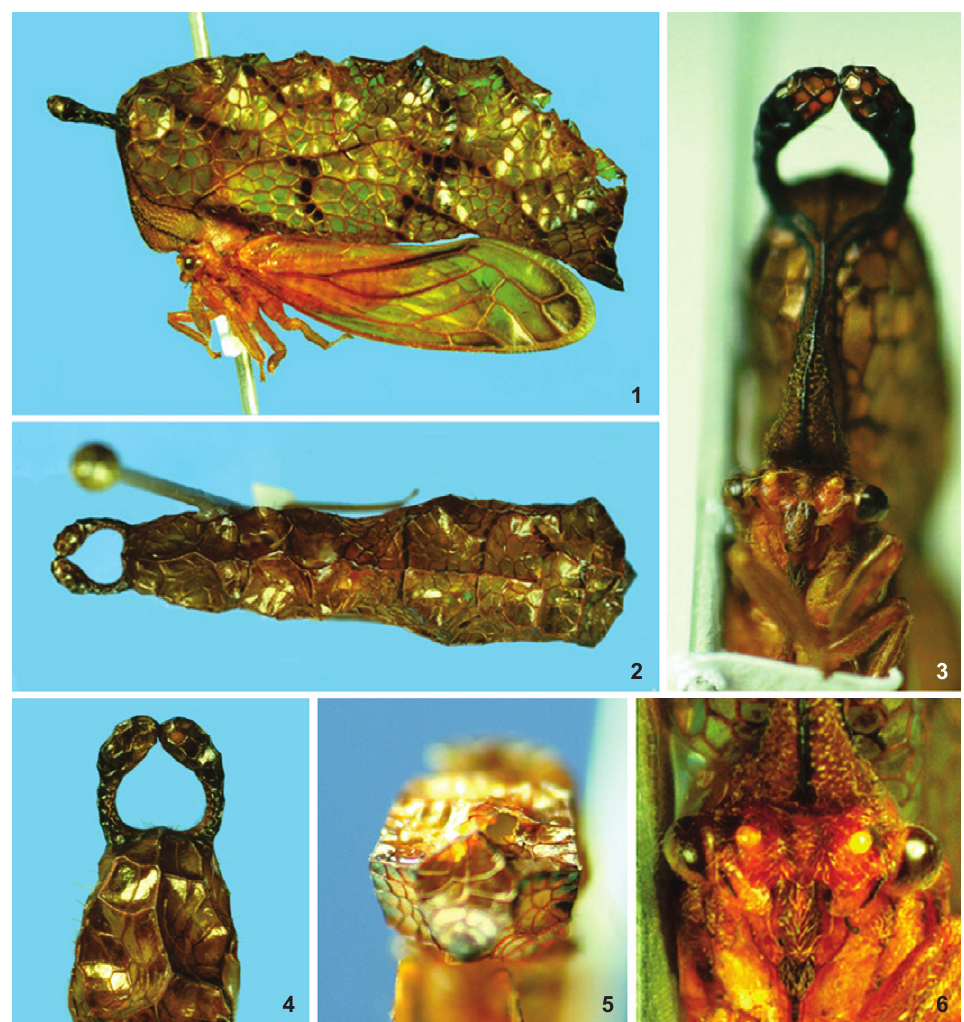
Figs 1-6. Oeda mielkei sp. nov. , holotype female, DZUP: (1) habitus in lateral view; (2) habitus in dorsal view; (3) head and suprahumeral horns in anterior view; (4) details of suprahumeral horns in dorsal view; (5) apex of posterior process in posterior view); (6) head in anterior